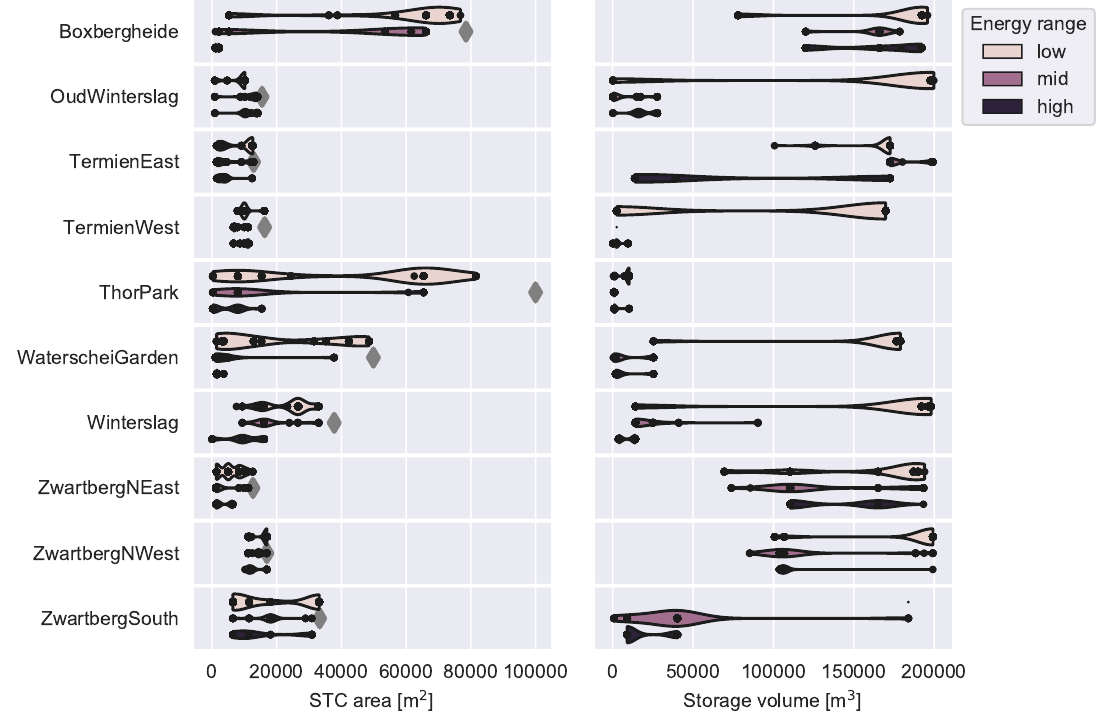
Figure 6. Distribution of solar and storage systems per network node. The Pareto-optimal solutions are split into high, mid and low energy import solutions. The left graph shows the maximum STC area per neighbourhood as the grey